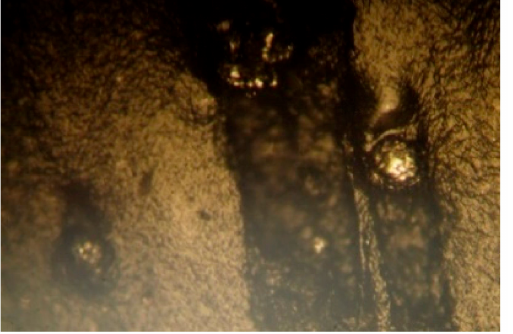
Figure 5. A fragment of a porous pipe in longitudinal section with visible pores.